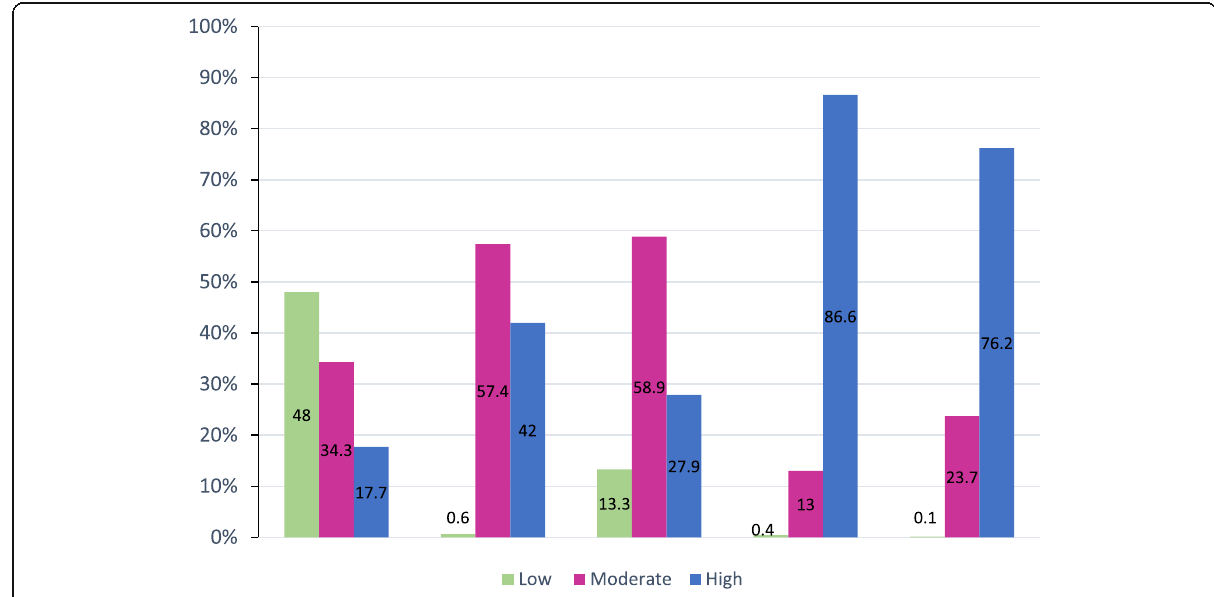
Fig. 3 Health beliefs of reproductive-age women in Alexandria regarding TTV and MNT,